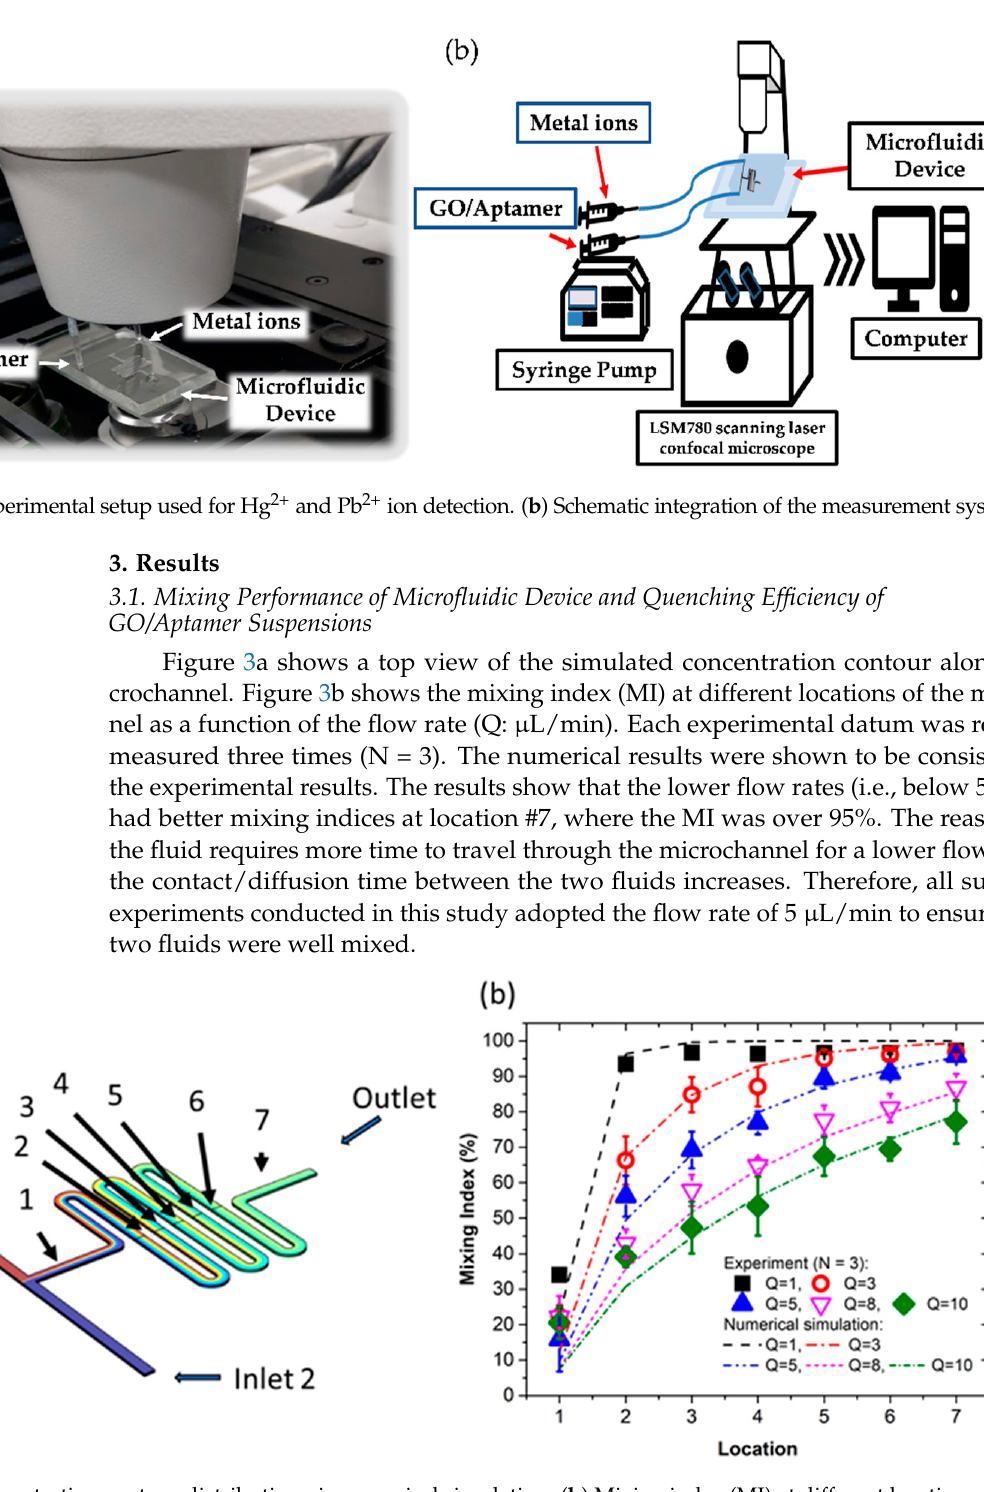
Figure 2. ( a ) Experimental setup used for Hg 2+ and Pb 2+ ion detection. ( b ) Schematic integration of the measurement system.